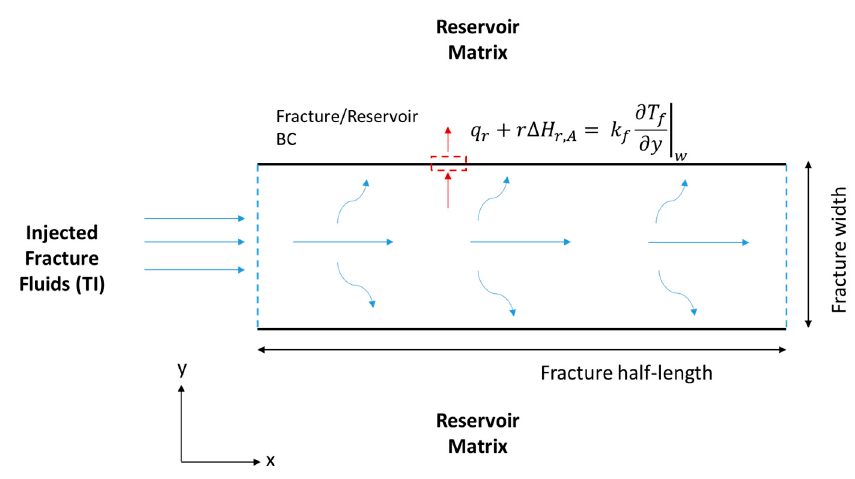
Figure 5. Schematic of the hydraulic fracture along the fracture length (x) and width (y), showing the energy balance BCs.